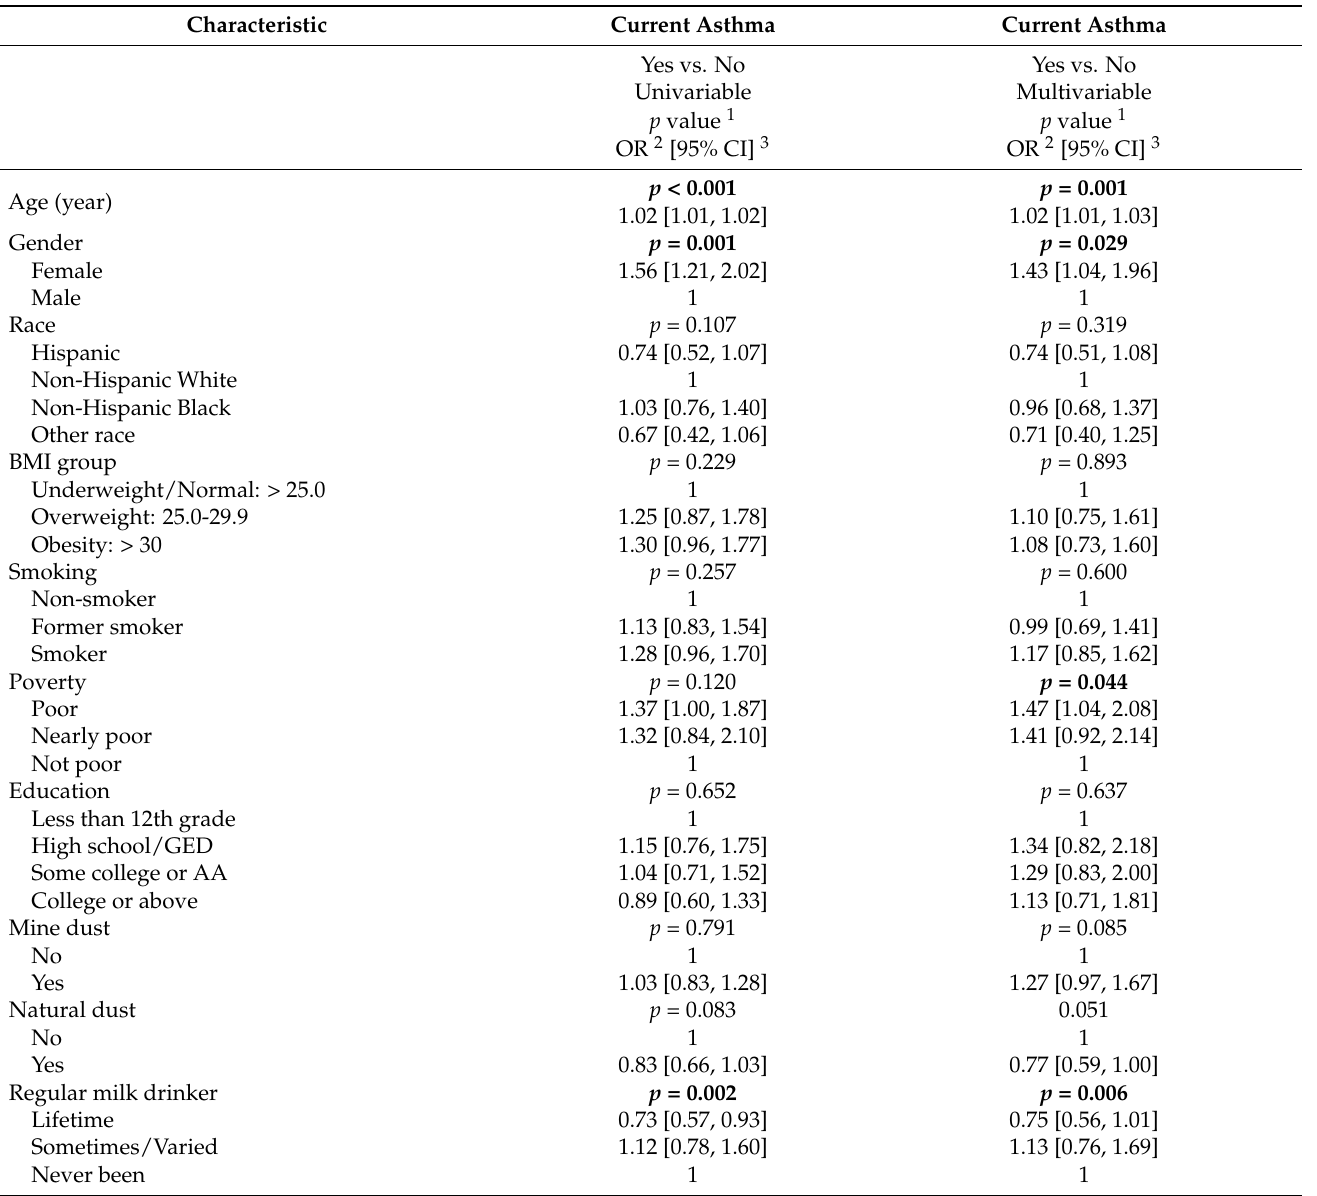
Table 4. Characteristics of milk drinkers and association to symptoms among participants reporting a history of asthma ( n =